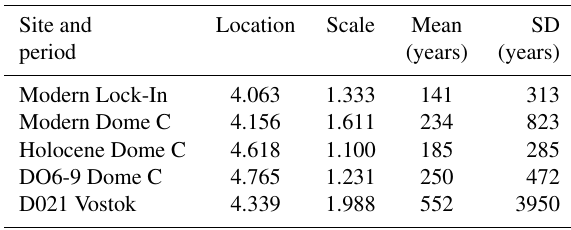
Table 2. Parameters defining the log-normal gas age distributions derived by comparison with weakly smoothed records. The location and scale parameters correspond to the µ and σ parameters used to define the log-normal law: GAD( a )